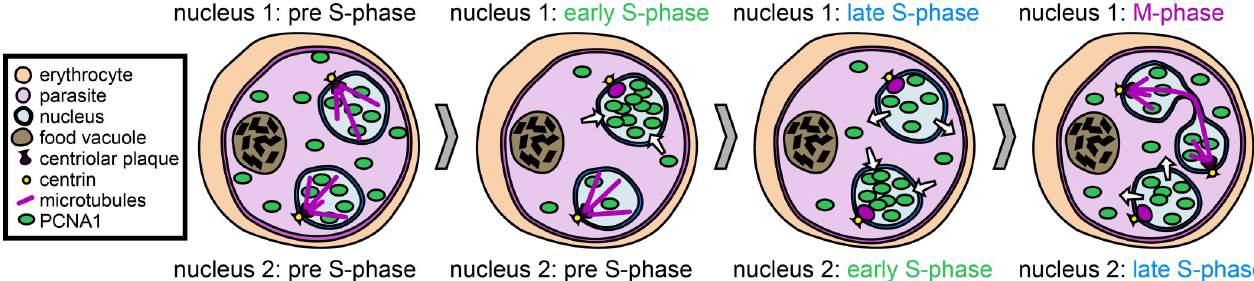
Fig 2. Nuclei cycle asynchronously in multinucleated parasites. After nuclear division, hemispindle structures remain briefly within the separated nuclei. In parasites with two nuclei, one may enter S–phase earlier than the other; S–phase entry is marked by the rapid accumulation of the replication marker PCNA1 within a nucleus. Asynchrony is visible in both S–phase and nuclear division, as nuclei may show nuclear accumulation of PCNA1 as well as different microtubule structures at different